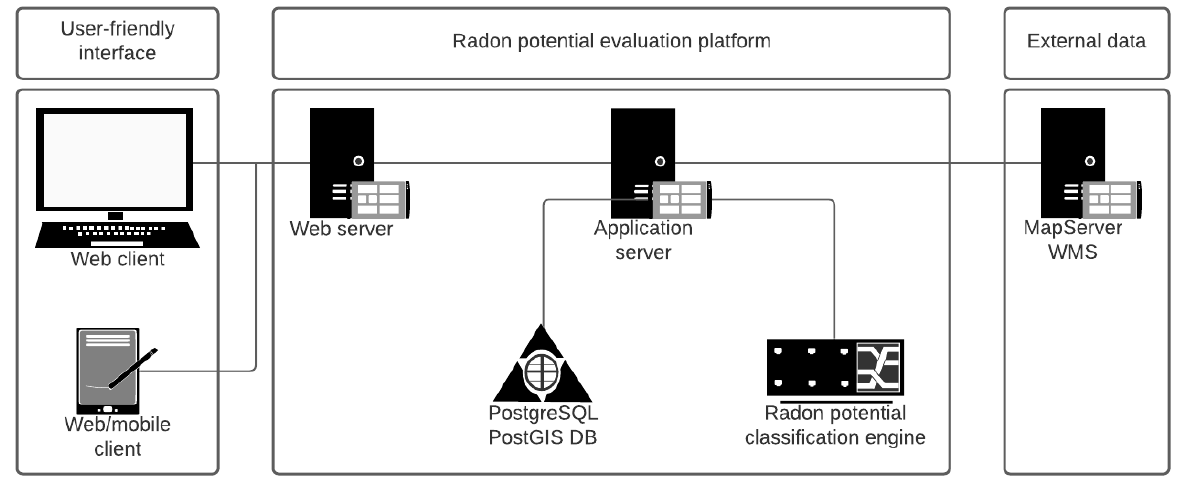
Figure 3. Radon potential evaluation platform designed by using a high-level architecture.